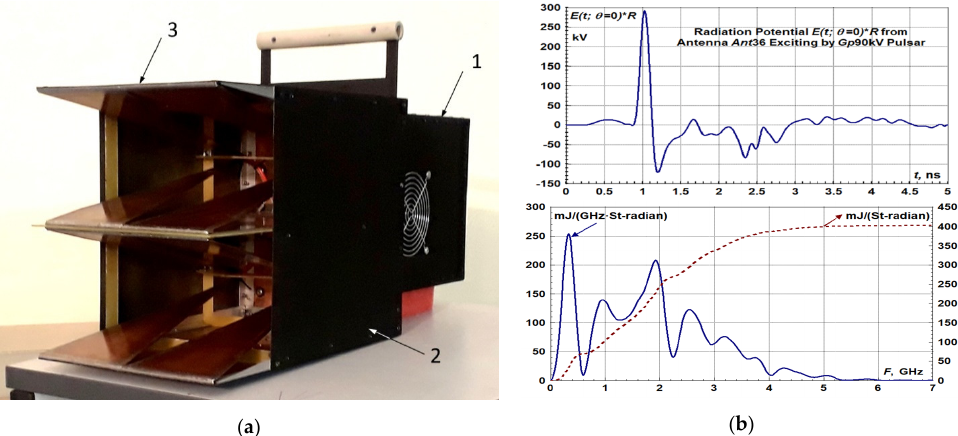
Figure 11. The UWB radiator (made in 2014 with a weight of 10 kg). ( a ) 1 = box with the pulser, DC source (accumulator assembly), and control device; 2 = antenna unit; 3 = shielding plate. ( b ) The radiation potential E ( t ) R measured on the radiator axis (top) and the energy spectrum density for one impulse (below).